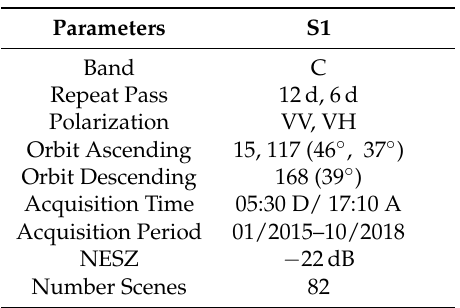
Table 2. Parameters of the acquired Sentinel-1 (S1) data. Values for the noise equivalent sigma zero (NESZ) were derived from [19]. The inclination angle of the respective orbits vary for locations within the areas of interest and consequently are given as approximate